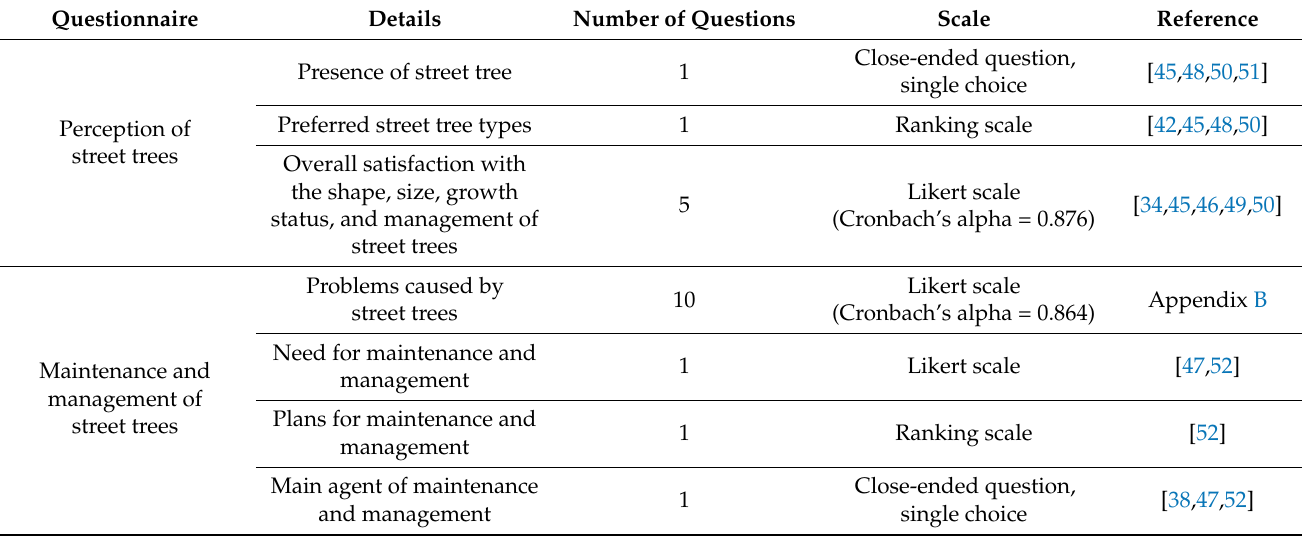
Table 1. Questionnaire and measurement scale for the satisfaction and problems associated with street